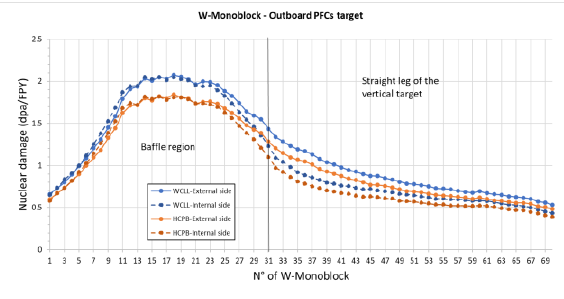
Figure 35. Outer poloidal profiles of the nuclear damage (dpa/FPY) on W-Monoblocks, comparing the values on the external and innermost target sides, both for WCLL and HCPB blanket case.